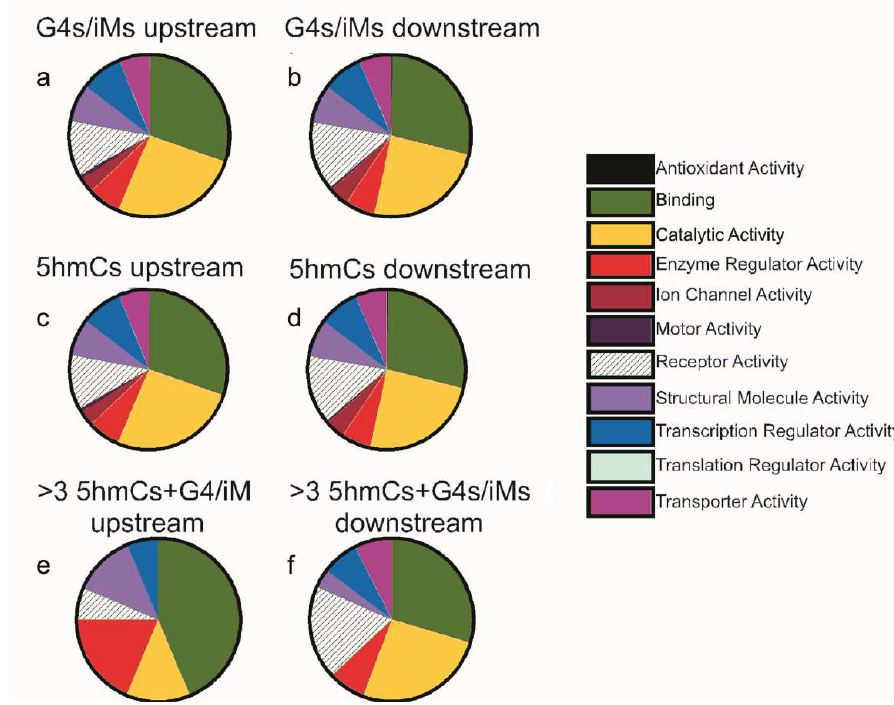
Figure 4. PANTHER pie charts showing the molecular function distributions of G4/iM-forming genes (irrespective of whether or not 5hmC-modifications) ( a ) upstream of TSS, and ( b ) downstream of TSS; 5hmC-containing genes (irrespective of presence of G4s/iM-forming sequences) ( c ) upstream and ( d ) downstream of the TSS; iM-forming genes that have 3 or more 5hmCs associated with them ( e ) upstream, and ( f ) downstream of the TSS.